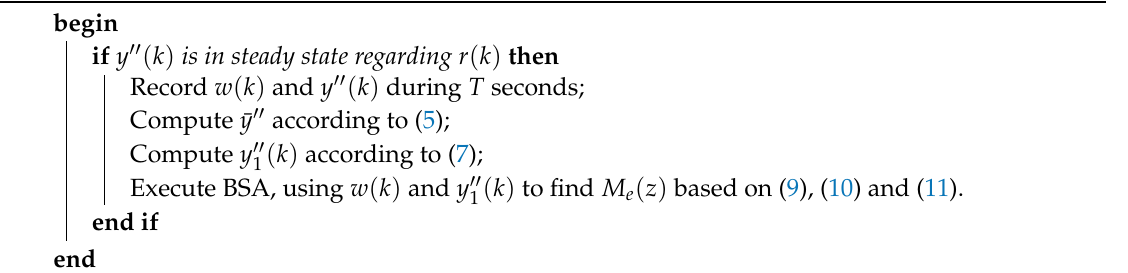
Algorithm 1: Attack Identification without the NII